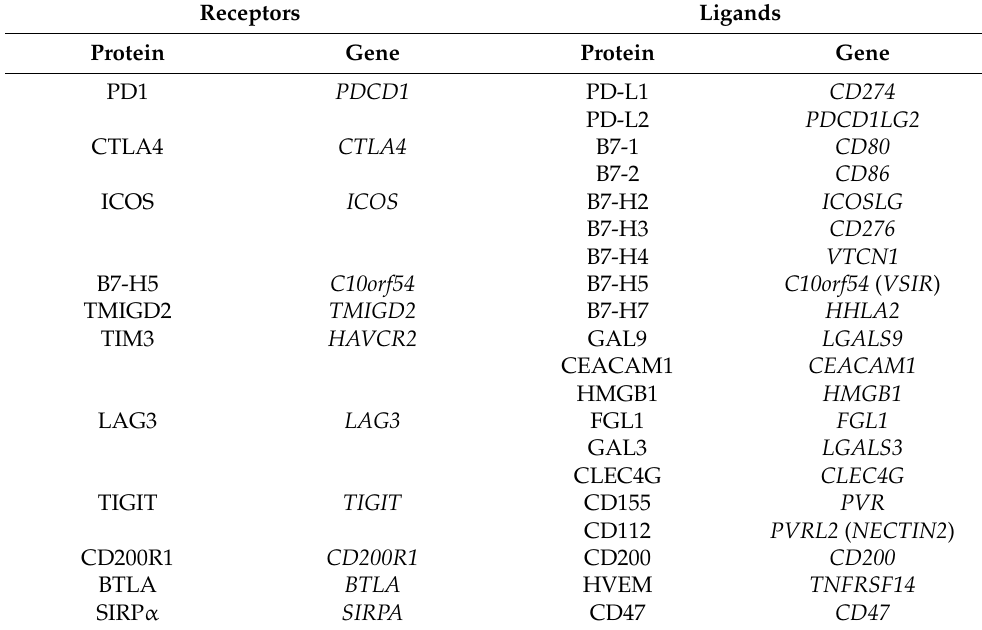
Table 1. Placental inhibitory immune checkpoint receptor/ligand